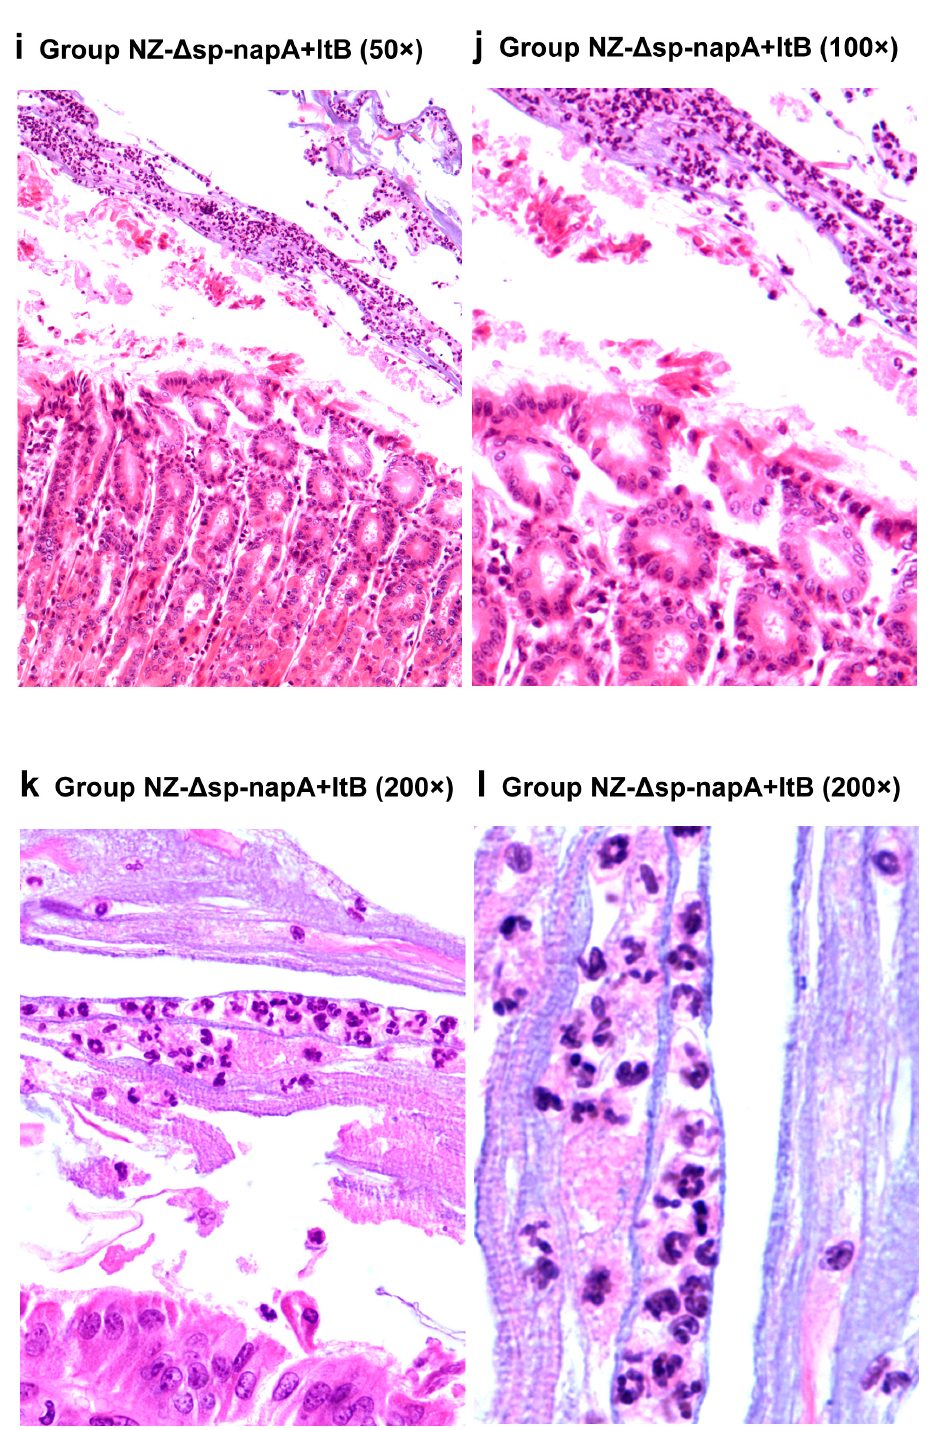
Figure 9. Distribution of leukocytes in gastric mucus of the NapA+LtB immunized mice ( i – l ). NZ- Δ sp-napA+ltB group ( n = 11) were challenged with H. pylori following gavages with mixture of NZ3900/pNZ- Δ sp- napA and -sp- ltB . The gastric tissues were sampled from the mice 1 week after the challenges and examined via paraffin section and hematoxylin-eosin staining. Leukocytes including neutrophils, macrophages and lymphocytes accumulated in the deep and superficial mucosa and gastric mucus.